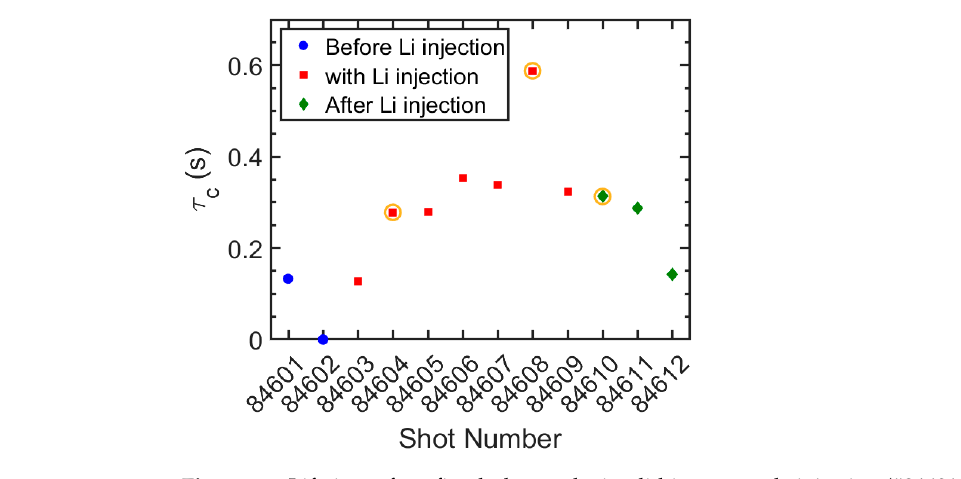
Figure 12. Lifetime of confined plasma during lithium granule injection (#84601–#84612). The orange circles indicate the discharges in which an early disruption occurred.